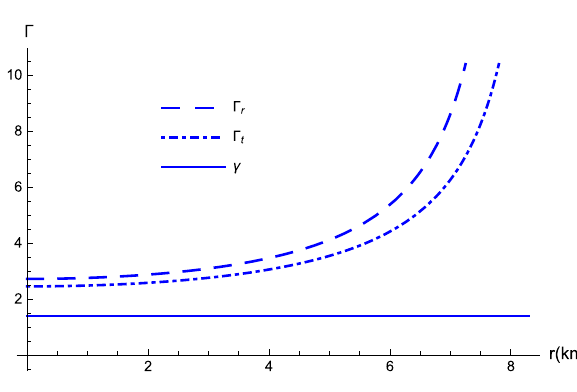
Fig. 7 Cracking condition